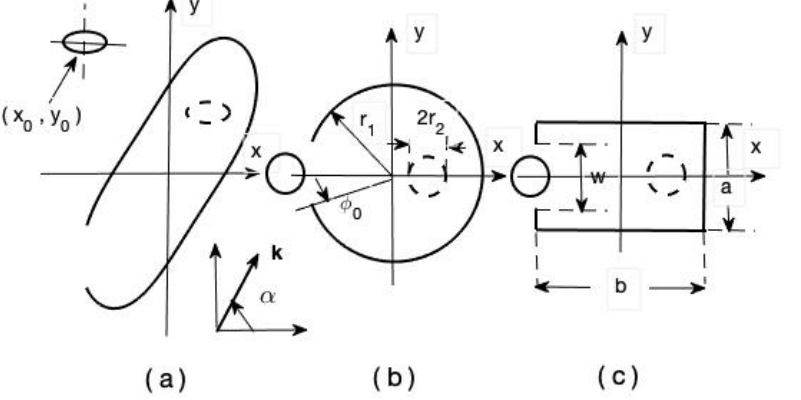
Figure 1. Problem geometry: ( a ) slotted cavity and rod (centre ( x 0 , y 0 ) ), both of arbitrary shape; ( b ) slotted circular cavity and circular rod (wire); ( c ) slotted rectangular cavity and circular rod (wire). Some alternative locations of the rod are shown in dashed line.